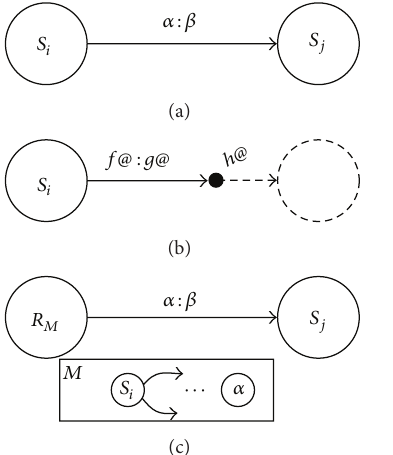
Figure 1: Examples of situations, expectations, and actions. (a) Typical SitLog arc, (b) functional arc, and (c) recursive situation.